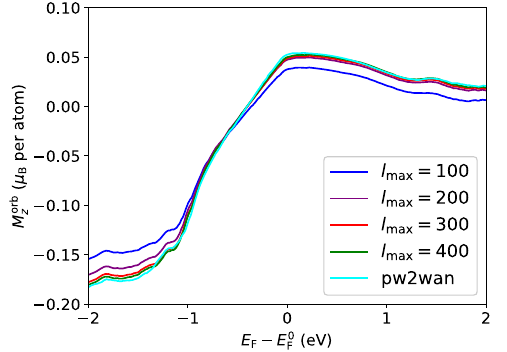
Fig. 5 Orbital magntization of bcc Fe. Given as a function of the Fermi level E F relative to the pristine Fermi level E 0 using the .uHu fi le computed with pw2wannier90.x (dashed line) and using the wannierberri.mmn2uHu interface (solid lines) with different summation limit l max in